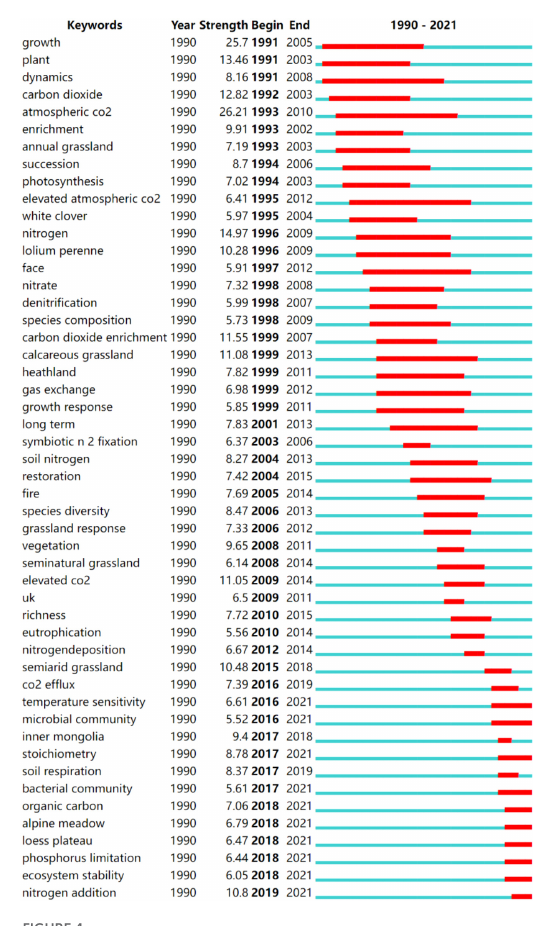
FIGURE4 Top 50 keywords with the strongest citation bursts (the red bars indicate some keywords cited frequently; the green bars indicate keywords cited